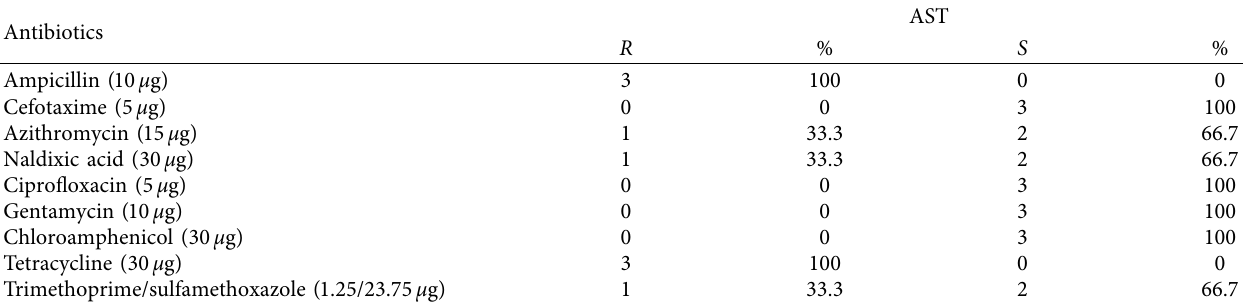
Table 5: Antibiotic sensitivity pattern of Shigella flexneri isolated from stool specimens of food handlers in public hospitals, Addis Ababa, Ethiopia, March to June 2017.